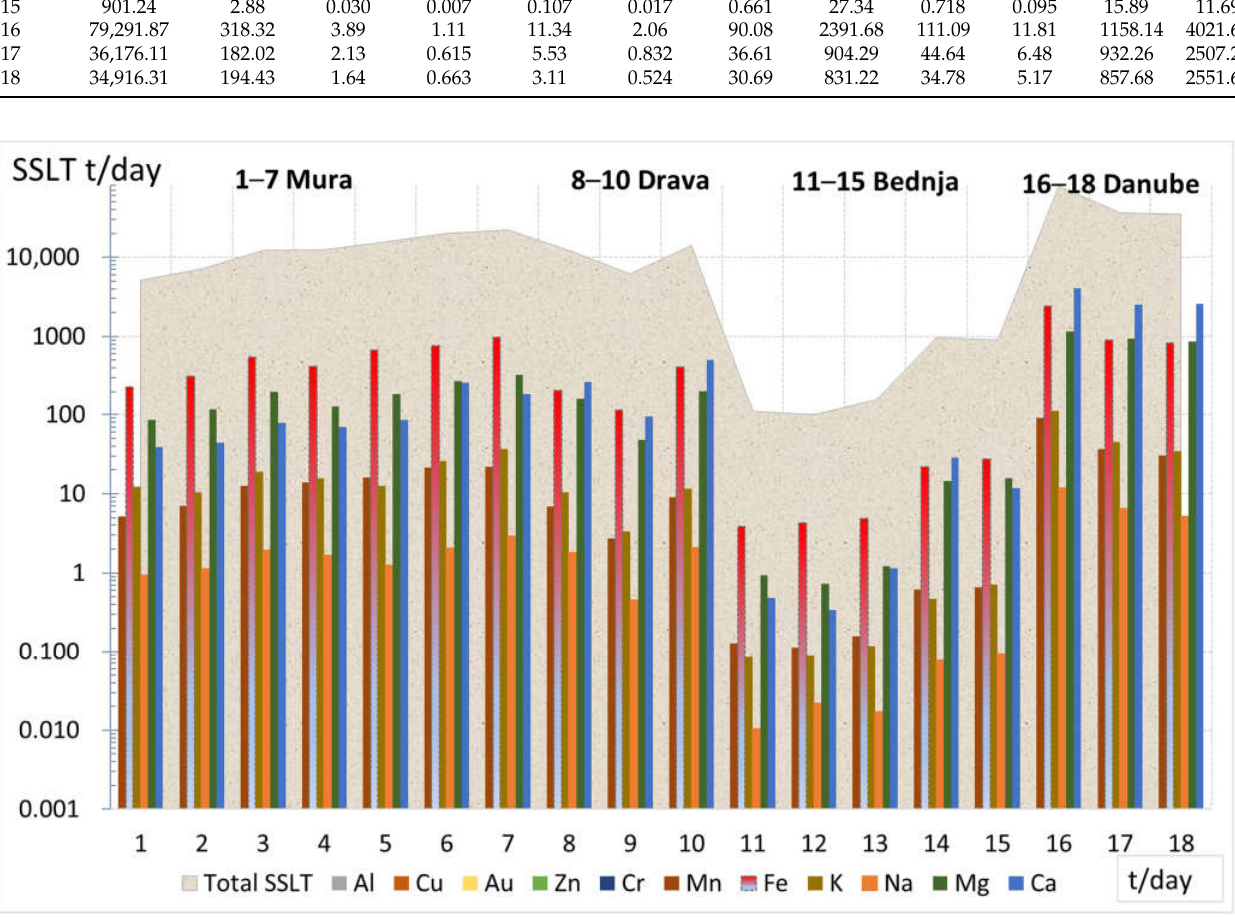
Figure 6. The total amount of metals (t/day) in daily SSLT. Table 4. The total amount of metals (kg/day) in daily SSLT. Table 4 and the graphic in Figure 7 highlight the extreme daily value of mercury of 119 kg in Terezino Polje on 3 May 2019. Due to the high flow of the Danube River and the significant daily amounts of SSLT at HS Batina, the concentration of mercury increased during the peak flow in June and ranged between 11.78 and 12.74 kg per day. Unlike other cross-border rivers, in the Bednja tributary in the profile of HS Željeznica (samples No. 11–15), the values of mercury concentration were minimal and ranged from 0.009 to 0.114 kg per